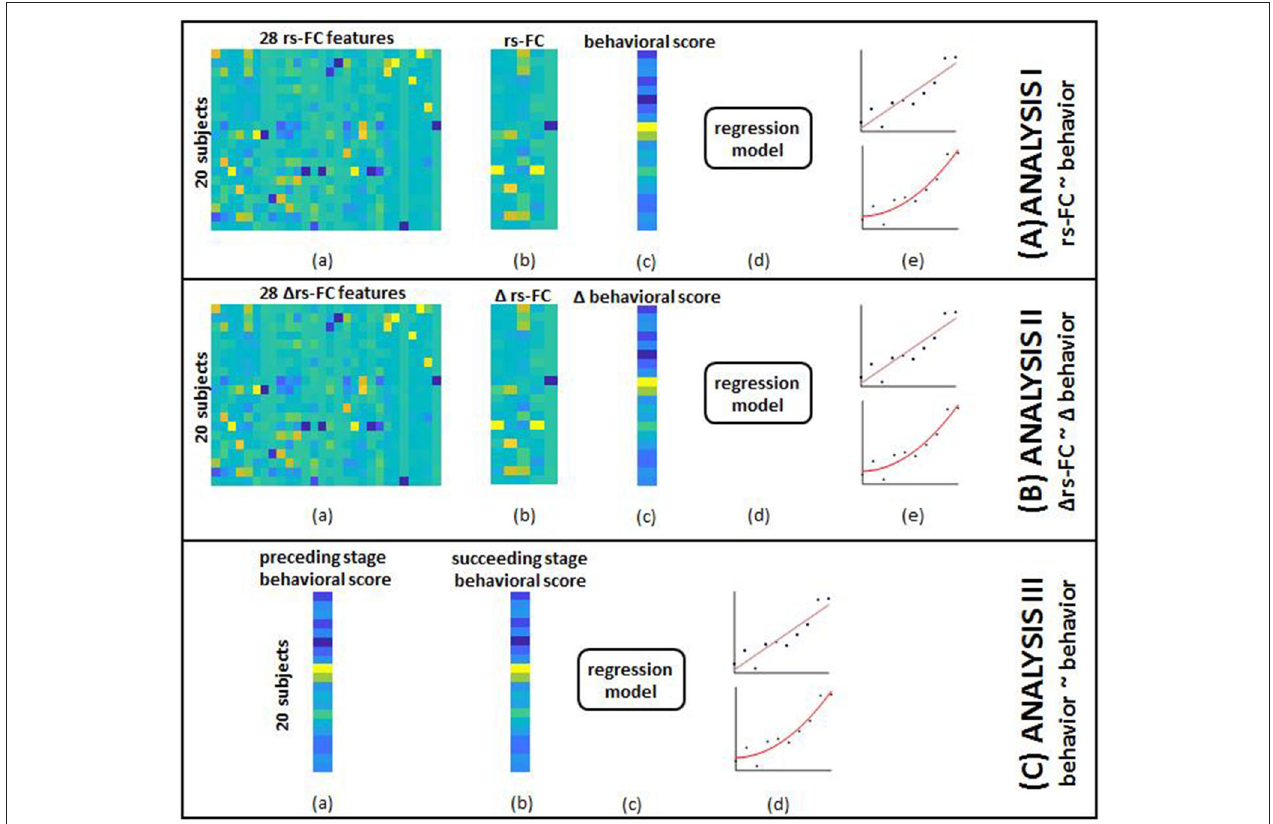
FIGURE 4 | The overview of group-level analysis is provided here. (A) rs-FC correlates of behavior: (a) aggregated data from single-subject analysis gave 28 rs-FC features for each of the 20 subjects; (b) SFS was used to select specific correlates corresponding to each behavioral outcome; (c) aggregated behavioral scores for 20 subjects served as outcomes in separate models; (d) data from (b) and (c) were fed into the SVR model; (e) linear (top) and non-linear (bottom) kernels were specified to perform regression. Steps (a through e) were repeated by adding identified clinical variables to rs-FC data as input features. (B) 1 rs-FC correlates of 1 behavior: (a) aggregated data from single-subject analysis gave 28 change in rs-FC features for each of the 20 subjects between pairs of time-points; (b) SFS was used to select specific correlates corresponding to each behavioral outcome; (c) aggregated change in behavioral scores between corresponding pair of time-points for 20 subjects served as outcomes in separate models; (d) data from (b) and (c) were fed into the SVR model; (e) linear (top) and non-linear (bottom) kernels were specified to perform regression. Steps (a–e) were repeated by adding identified clinical variables to change in rs-FC data as input features. (C) behavioral correlates at preceding time-point of behavior at succeeding time-point: (a) aggregated behavioral scores from a preceding time point gave 8 distinct measures; (b) aggregated behavioral scores from a succeeding time-point gave the corresponding 8 measures; (c) data from steps (a) and (b) were fed to the SVR model; (d) linear (top) and non-linear (bottom) kernels were specified to perform